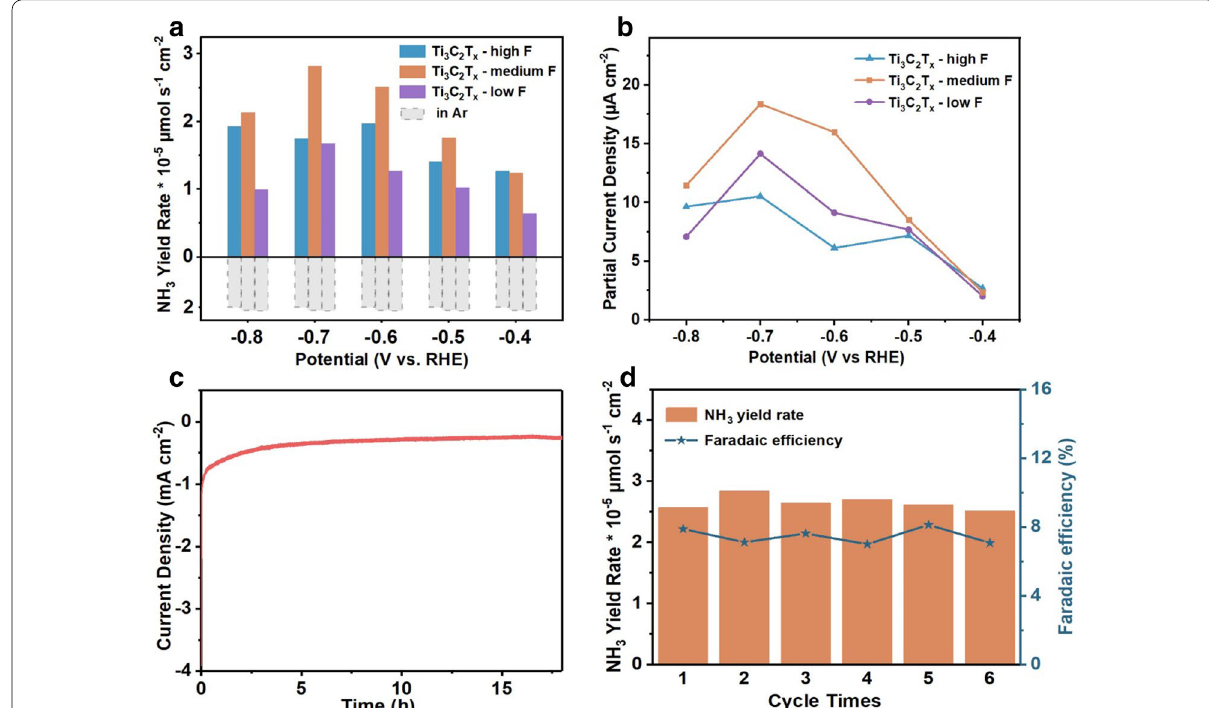
Fig. 4 a The ammonia production rates and b partial current densities of NH 3 production of Ti 3 C 2 T x MXene samples with different surface densities of fluorine terminal groups. c Chronoamperometry curve of Ti 3 C 2 T x ‑medium F MXene for 18 h under ‒ 0.7 V. d The NH 3 yield rate (left y‑axis) and Faradaic efficiency (right y‑axis) of Ti 3 C 2 T x ‑medium F MXene at ‒ 0.7 V for 6